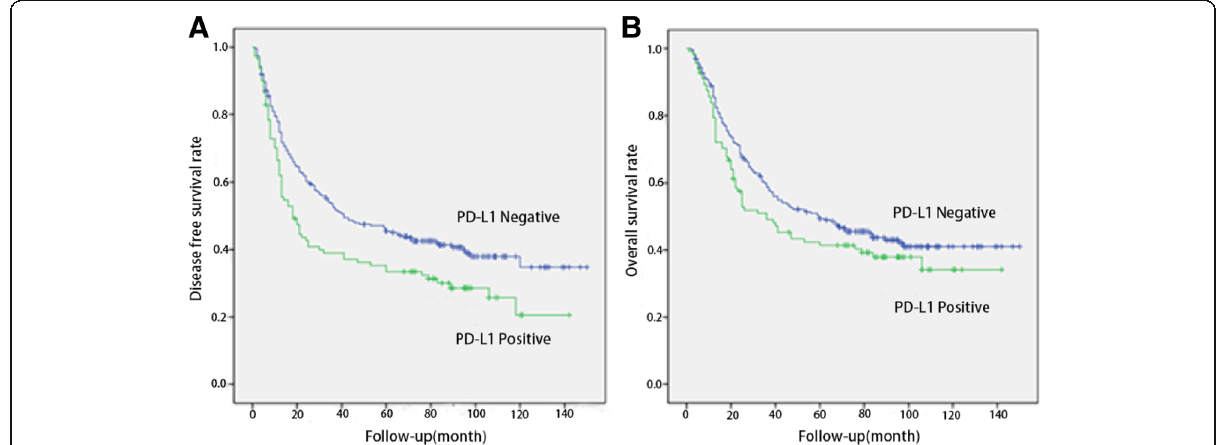
Fig. 3 Kaplan-Meier curves of disease-free survival (DFS) and overall survival (OS) in esophageal squamous cell carcinoma (ESCC) based upon PD-L1 expression in tumor cells. a Patients with PD-L1 expression had significantly shorter DFS than those without PD-L1 expression (median DFS time: 18 verse 41 months, P = 0.008). b There was no statistically significant difference in OS between the patients with positive and negative PD-L1 staining (median OS time: 36 verse 60 months, P =